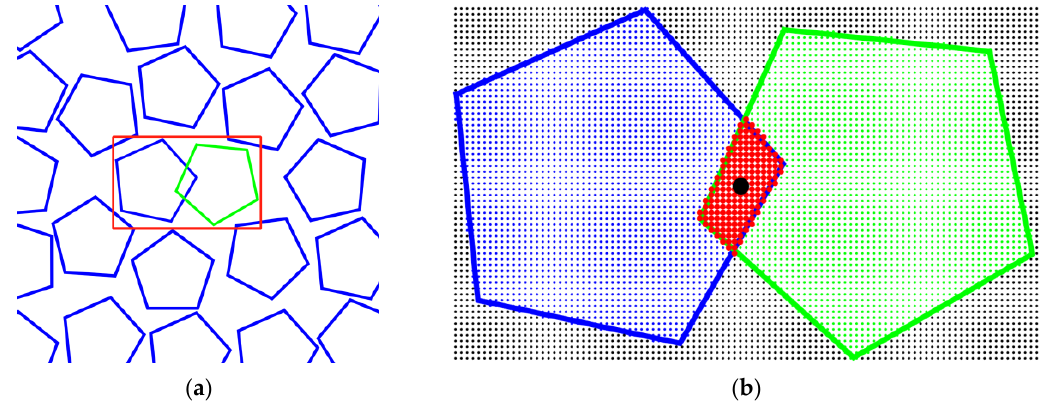
Figure 3. ( a ) A rectangle box surrounding two overlapping particles; ( b ) Point sampling details based on one-point correlation function: the red dots indicate the overlapped ones, and the black dot is the centroid. Table 4. Total consumption times of the CPU and GPU in calculation of one-point correlation function for packing system of regular pentagon.